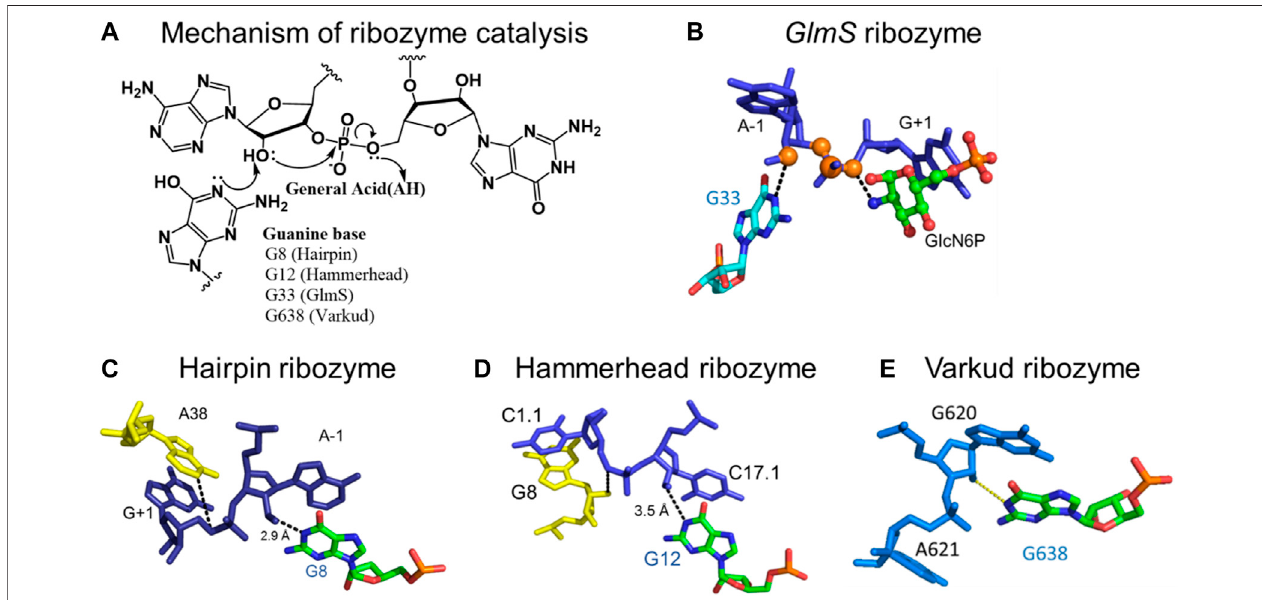
FIGURE 3 | Mechanism of the nucleolytic reaction catalyzed by small self-cleaving ribozymes. (A) Acid-base catalytic mechanism of small self-cleaving ribozymes andthepositionsofparticipatingcatalyticguanosinesintheactivesitesoftherespectiveribozymes. (B) Catalyticguanosine(G33)intheactivesiteofthe glmS ribozyme, in close proximity to the 2 ′ -hydroxyl of the A-1 nucleotide adjacent to the scissile phosphodiester bond. (C) The N1 of catalytic guanosine (G8) in the hairpin ribozyme in closeproximitytothe2 ′ -hydroxyloftheA-1nucleotide. (D) TheN1ofcatalyticguanosine(G12)inthehammerheadribozymeincloseproximitytothe2 ′ -hydroxylof the A-1 nucleotide. (E) The N1 of the catalytic guanosine (G698) in the Varkud Satellite ribozyme in close proximity the 2 ′ -hydroxyl of A-1 nucleotide. Figure 3E was shared by Joe Piccirilli ’ s laboratory at the University of Chicago (Suslov et al., 2015), and parts of the fi gure are adapted from reference (Singh et al., 2014) (CC BY